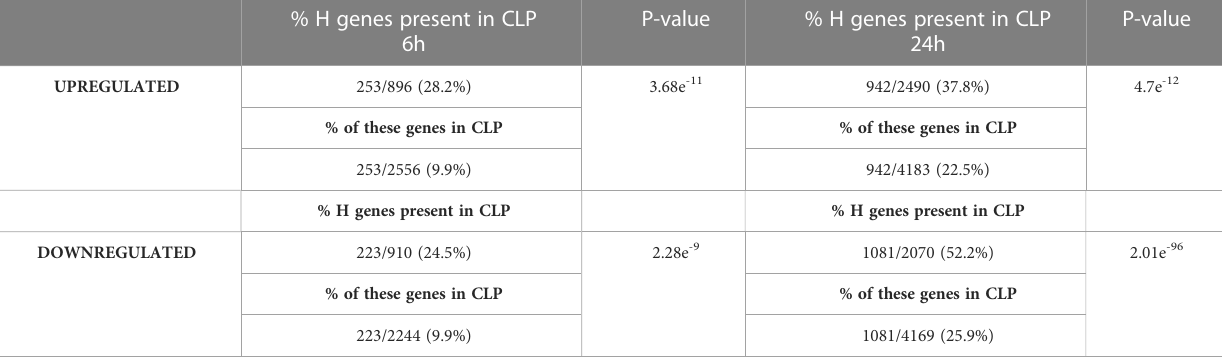
Table2displaystheamountofgenesthatareupregulated(adjustedP-value(P)<0.05andLFC>0)ordownregulated(P<0.05andLFC<0)byhypoxiaandhowmanyofthesegenesareinduced (P < 0.05 and LFC > 0) or repressed (P < 0.05 and LFC < 0) by CLP polymicrobial sepsis. Determining if twosets showed a signi fi cant overlap as approached as a (gene) set enrichment analysis, the hypergeometric test was used to obtain a p-value of the overlap. As the population size for the test, we used the total number of genes (13.000 genes) for which we can reliably obtain